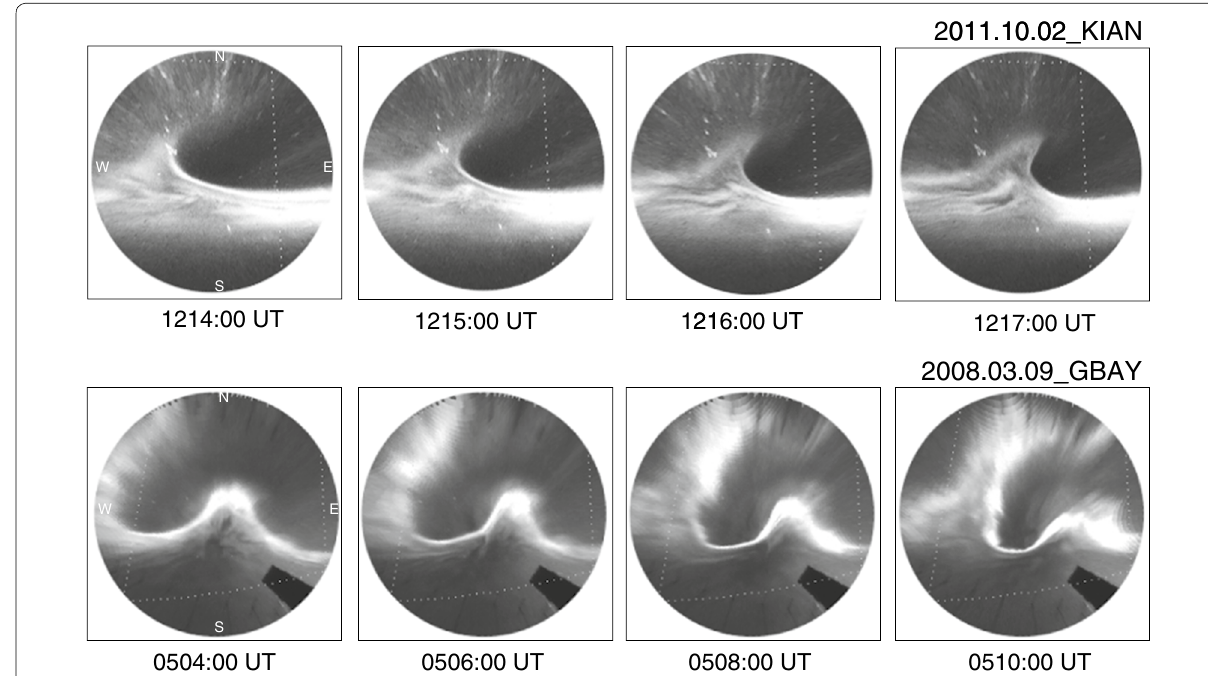
Fig. 4 Typical growth characteristics of O/T-type omega bands in which the T-type structure is that of a tongue ( upper row ) and a torch ( lower row